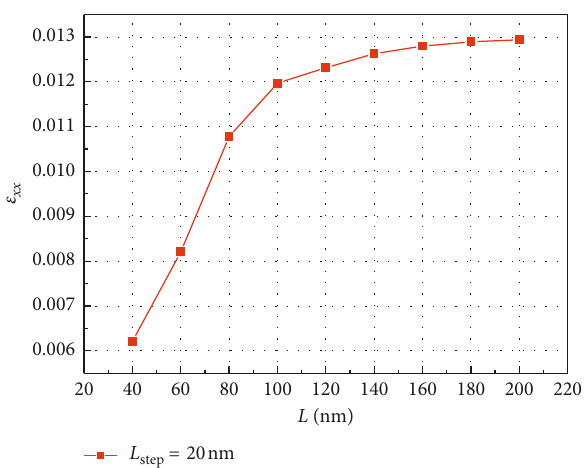
Figure 9: Variation of strain with the width of the epitaxial layer when the width of the Ge step is 20nm.